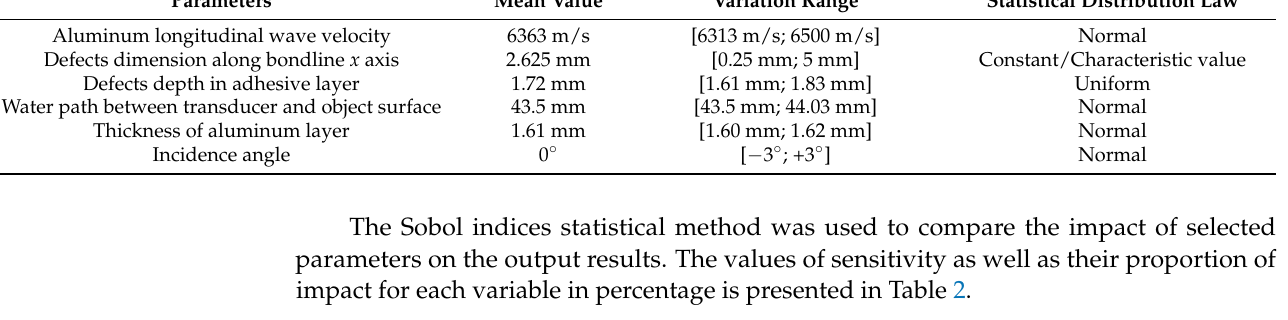
Table 2. Values of sensitivity and proportion of parameters impact.